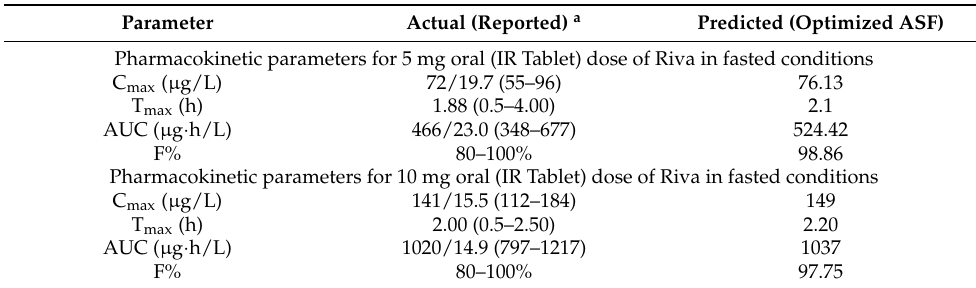
Table 6. Pharmacokinetic parameters for IR Tablet in fasted